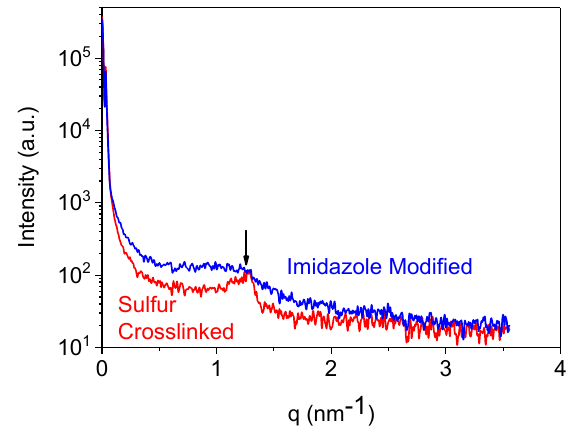
Figure 5. SAXS profiles of sulphur cured BIIR and imidazole modified BIIR.